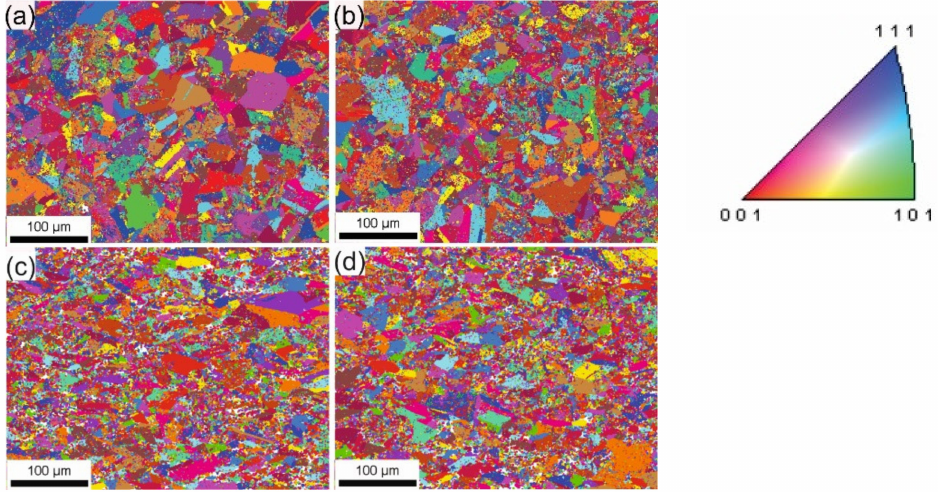
Figure 13. Micrograph of the as-received tube at ( a ) max and ( b ) min positions, ( c ) max side of the drawn tubes with 0 ◦ tilting, and ( d ) − 5 ◦ tilting angle.